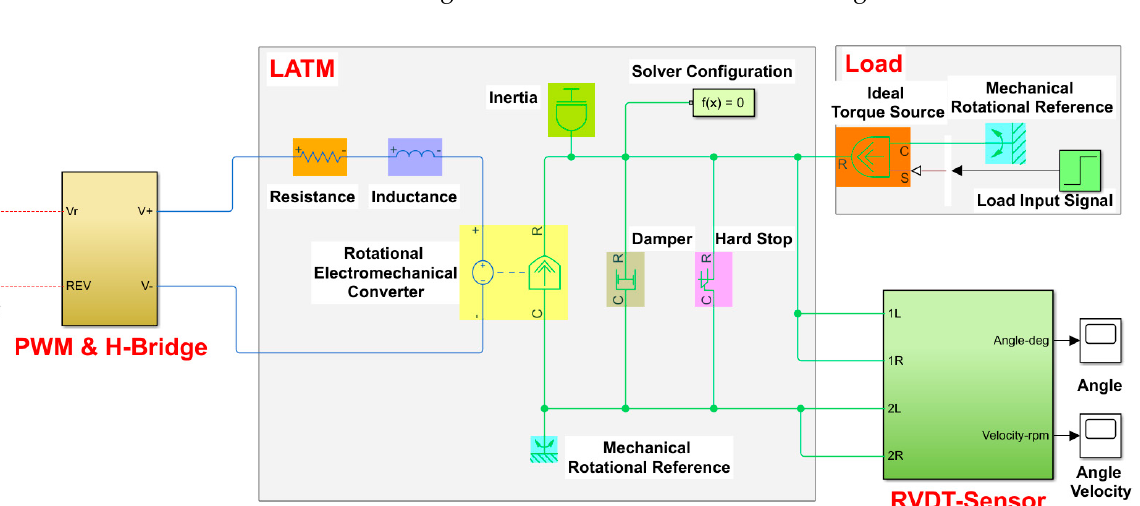
Figure 6. Schematic diagram of “H-bridge”.